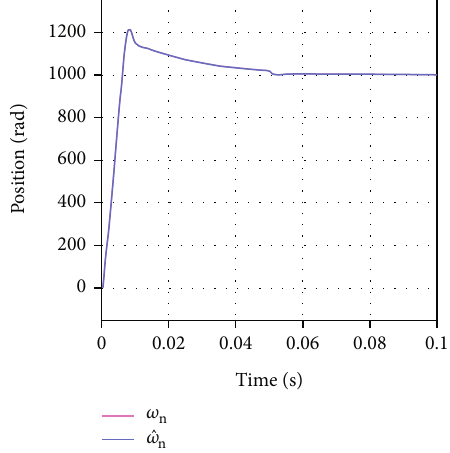
Figure 21: Estimated speed and actual speed for LO.